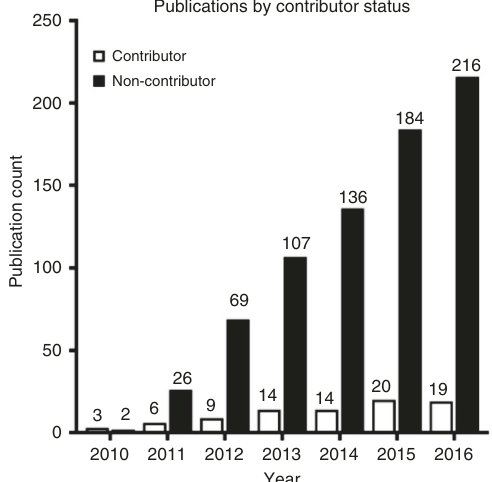
Fig. 3 Data use by authors. Breakdown of publications by contributor